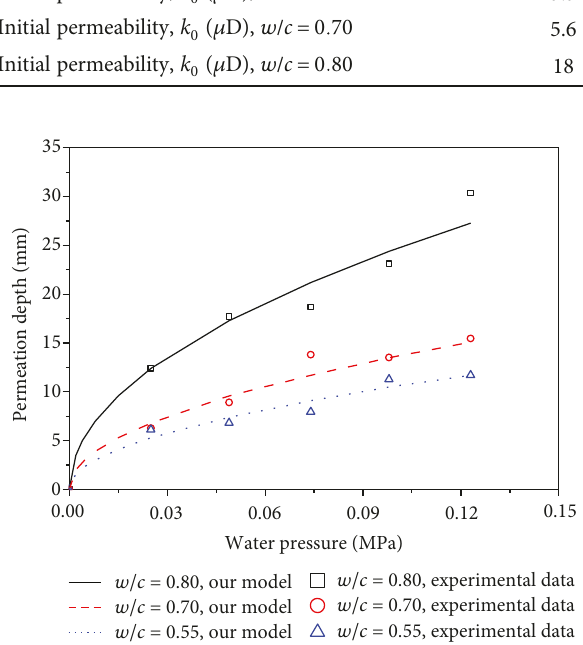
Figure 3: Comparison of numerical results by our model with the experimental data by Murata et al.